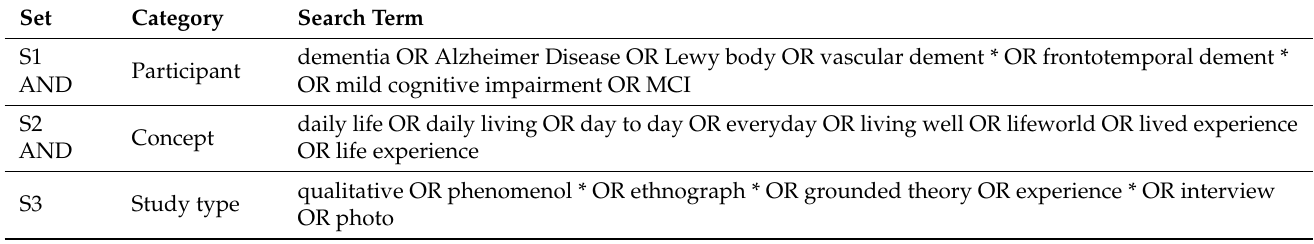
Table 2. Search terms of